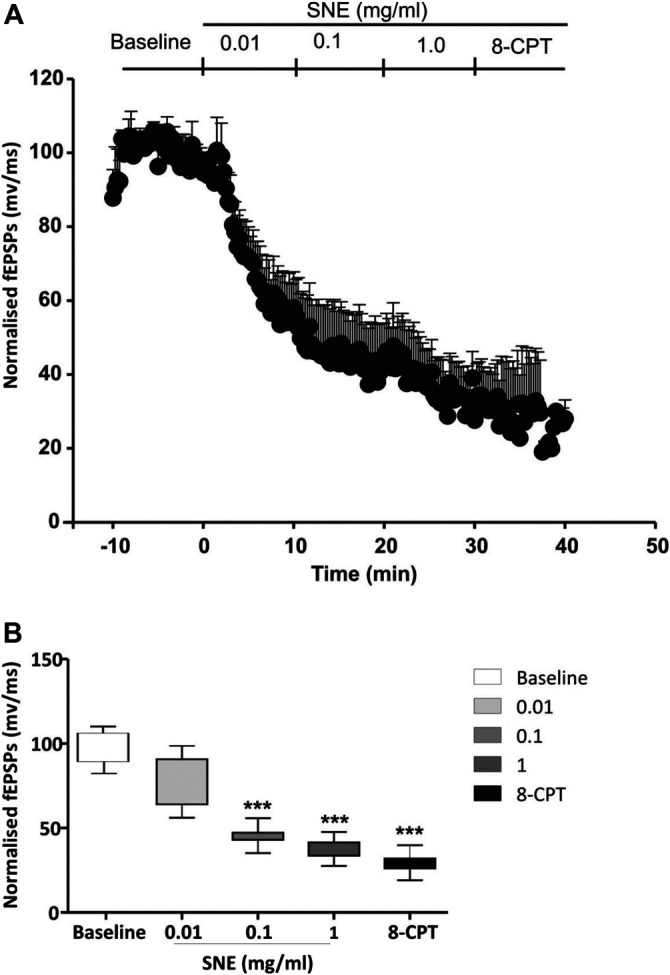

(A) Administration of 8-CPT (4 µM) after SNE (0.01, 0.1 and 1.0 mg/ml) on slope of fEPSPs in rat hippocampal slices after a stable baseline perfused with normal aCSF. (B) The box and whiskers graph is the total effect calculated form the AUCs of the graph above it. Data is mean ± SEM (n = 3). ***p < 0.001 compared with baseline, one-way ANOVA followed by a Dunnett’s multiple comparison test.